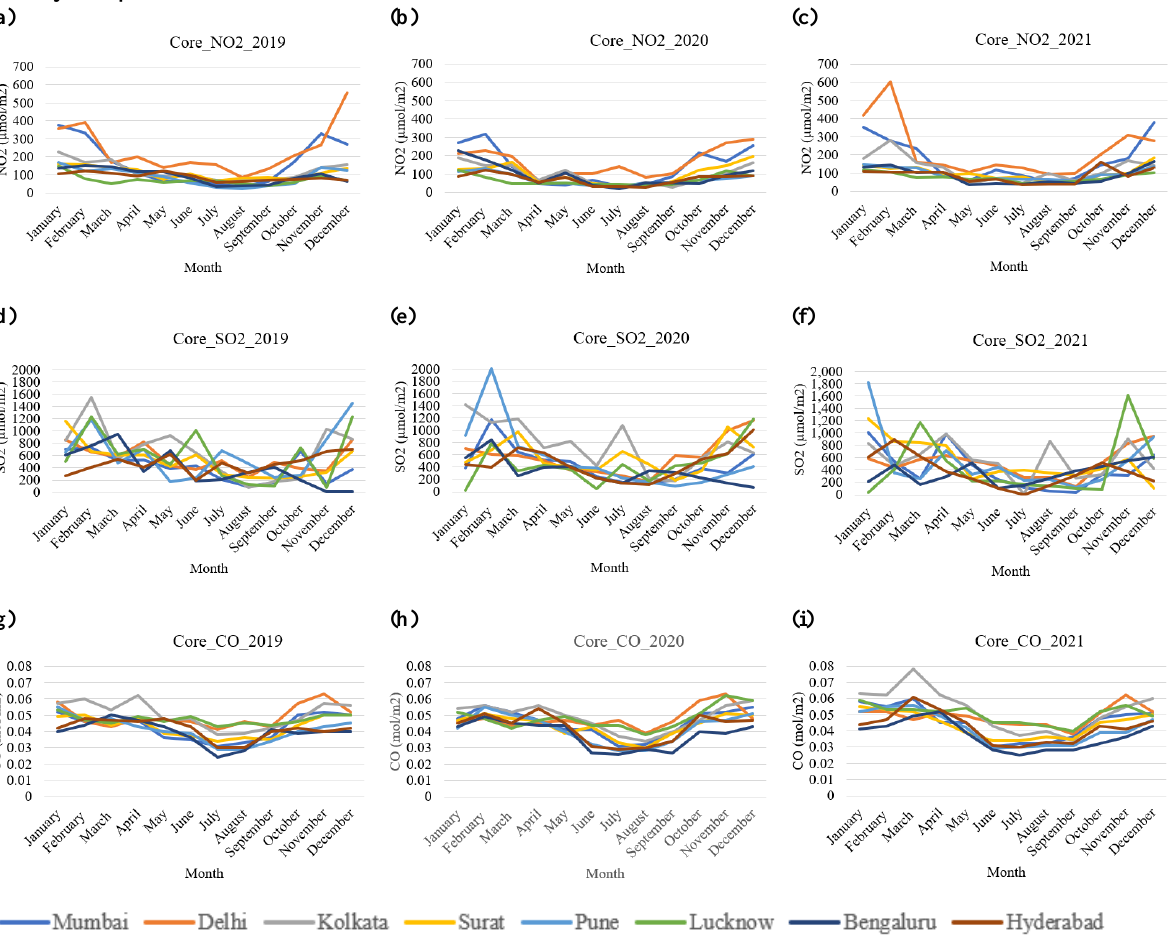
Figure 3. Pollutants concentration in core area of